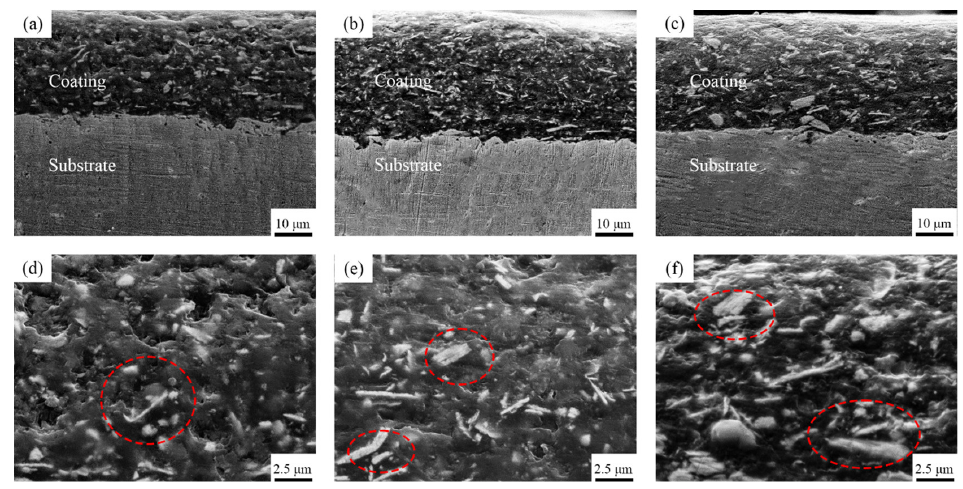
Figure 3. Cross-sectional micromorphology of composite coatings. ( a ) T1.5 coating; ( b ) T2 coating;